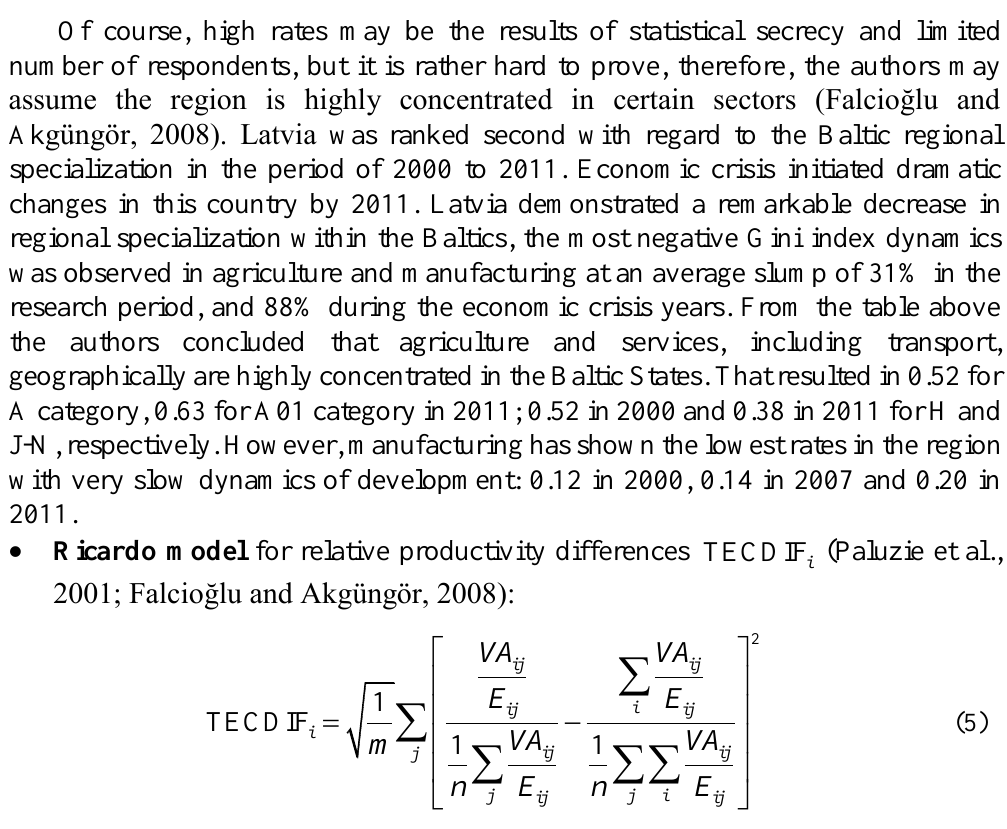
Table 5. Gini index calculation results: geographical concentration of the analyzed commercial economy sectors in the Baltic States according to NACE rev.2 coding from 2000 to 2011, points [calculation and development made by authors] Year/ A B-E F G, I H, J-N A01 C NACE coding 2000 0.45 0.13 0.11 0.29 0.52 0.51 0.12 2007 0.59 0.14 0.16 0.25 0.42 0.71 0.14 2011 0.52 0.18 0.17 0.30 0.38 0.63 0.20 dynamics, in %, 19.63 35.95 49.73 3.47 −28.90 27.73 2000–2011